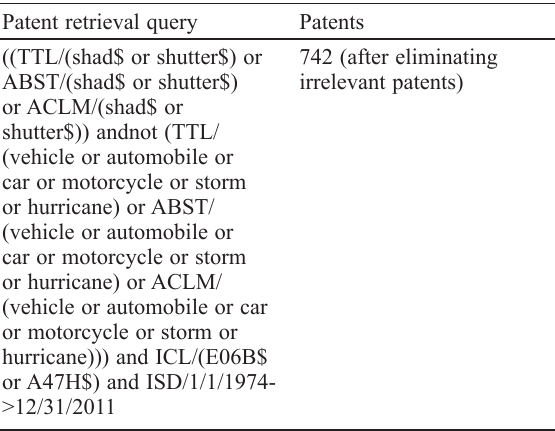
Table 1. Patent retrieval query from the USPTO